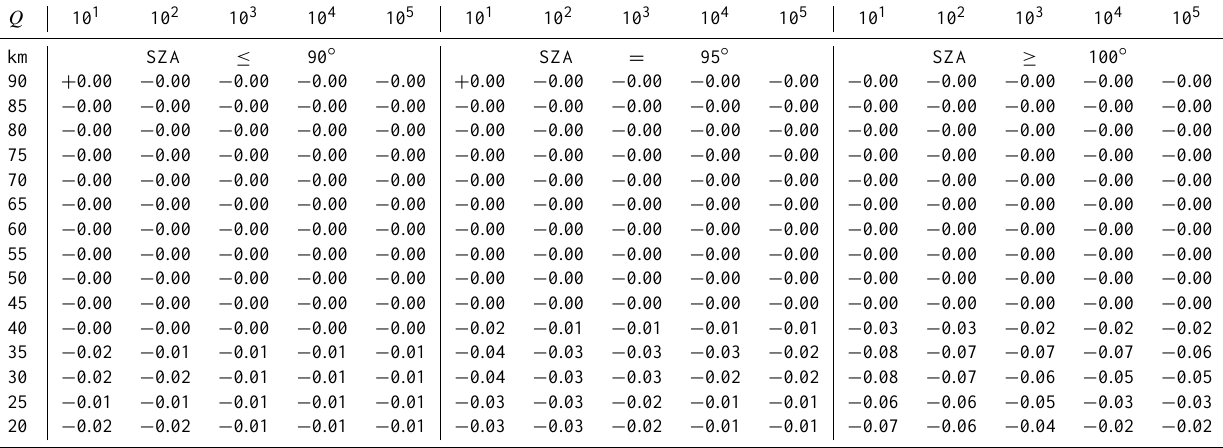
/Q for January SH. 2 O 5